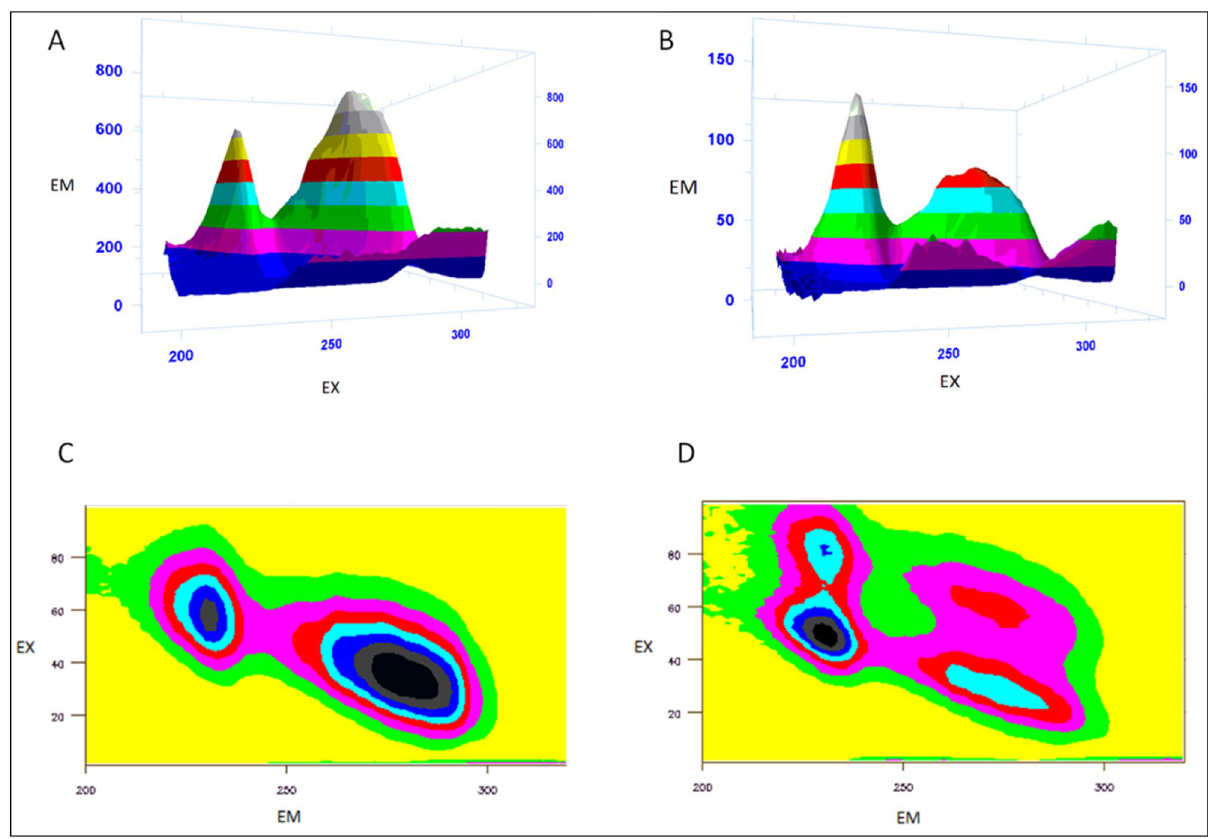
Figure 5. ( A , C ): 3D and contour plot of BSA (5 µM). ( B , D ) 3D and contour plot of BSA (5 µM) with MiADMSA (25 µM) (Carry Eclipse Win FLR software, version 1.1 (132)).